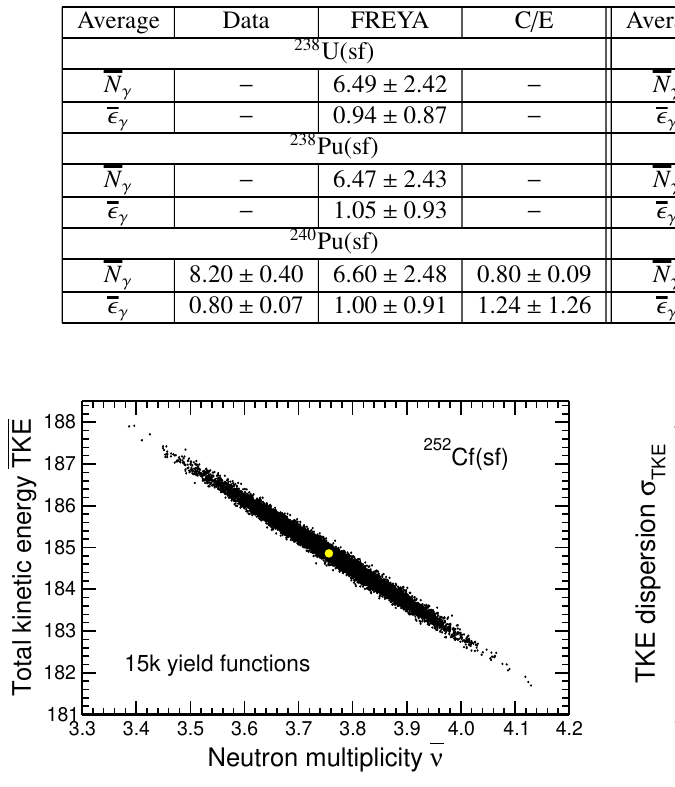
Figure 2. Scatter plot of σ ν and σ , obtained for each of the TKE 15,000 sampled yield functions. The overall average is